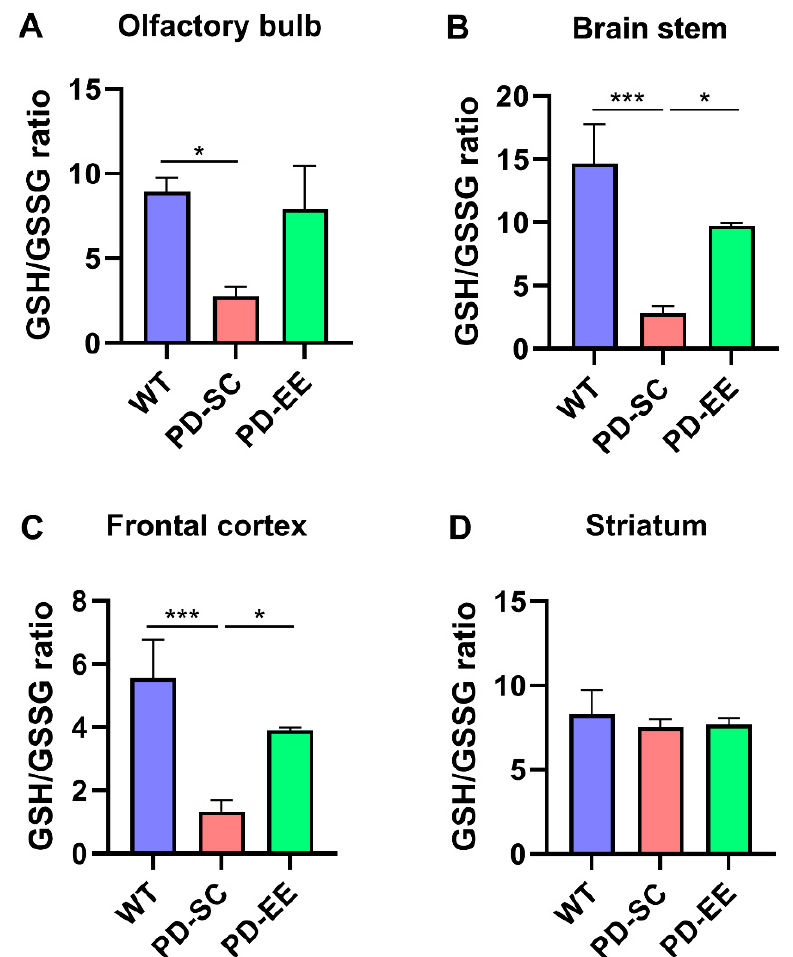
Figure 3. EE attenuated oxidative stress in the brain regions, except for the striatum. ( A ) The glutathione (GSH) / oxidized glutathione (GSSG) ratio was lower in the PD-SC mice than the WT mice in the olfactory bulb. ( B ) GSH / GSSG was lower in the PD-SC compared to the WT and PD-EE in the brain stem. ( C ) GSH / GSSG was lower in the PD-SC compared to the WT and PD-EE in the frontal cortex ( D ) In